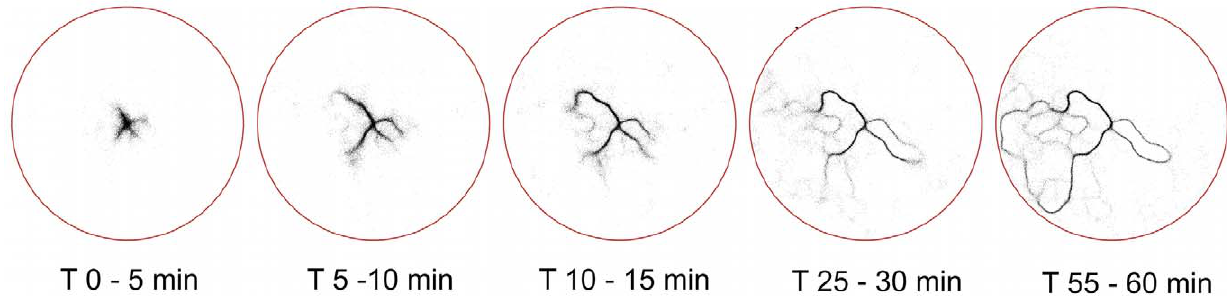
Figure 9. Output of the multi-agent simulation implementing the individual level parameters observed experimentally. Each image is obtained by summing 300 snapshots of the simulation taken at equal intervals of 1 second of simulation time (corresponding to 5 minutes of simulation) in a similar way to what had been done for the experimental data.